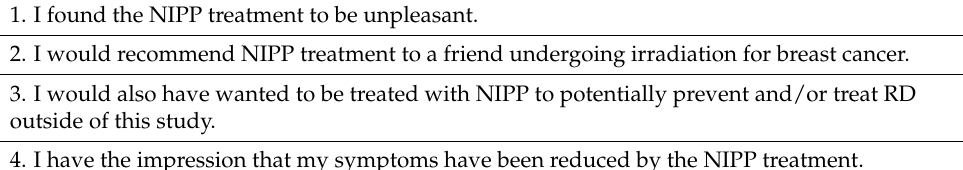
Table 1. The subjective experience of patients was monitored with four yes-no statements.